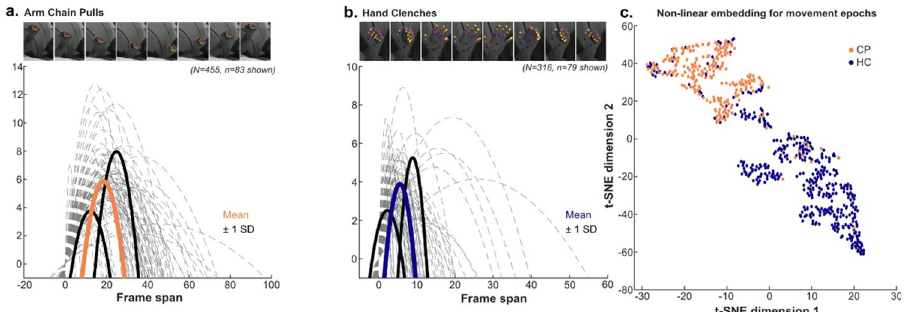
Fig 2. Movement epoch parabolic approximation and coefficient clustering. (A) Samples of parabolic fits for arm chain pulls displayed in light grey, alongside mean and standard deviation. (B) Samples of parabolic fits for hand clenches displayed in light grey, alongside mean and standard deviation. (C) Output of t-SNE (t-Distributed Stochastic Neighbor Embedding) to highlight distinct clusters of each movement type.